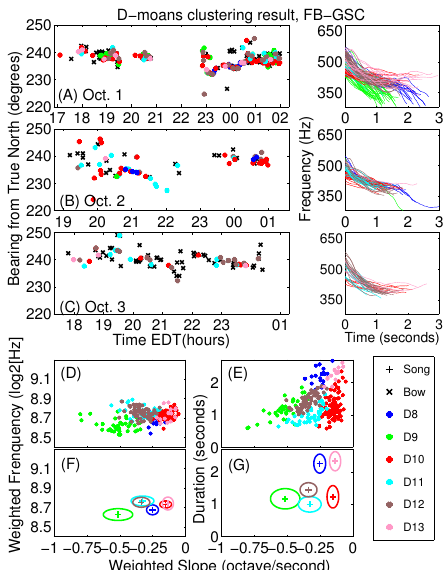
Figure A2. ( A – C ) Clustering of FB-GSC D-moans from 1–3 October identified 6 distinct sub-types. ( D – G )All subplots are identical to Figure A1, except the results here are for the FB-GSC D-moans. The D-moan sub-type D9 is present on 1 October, but absent or negligible for 2 and 3